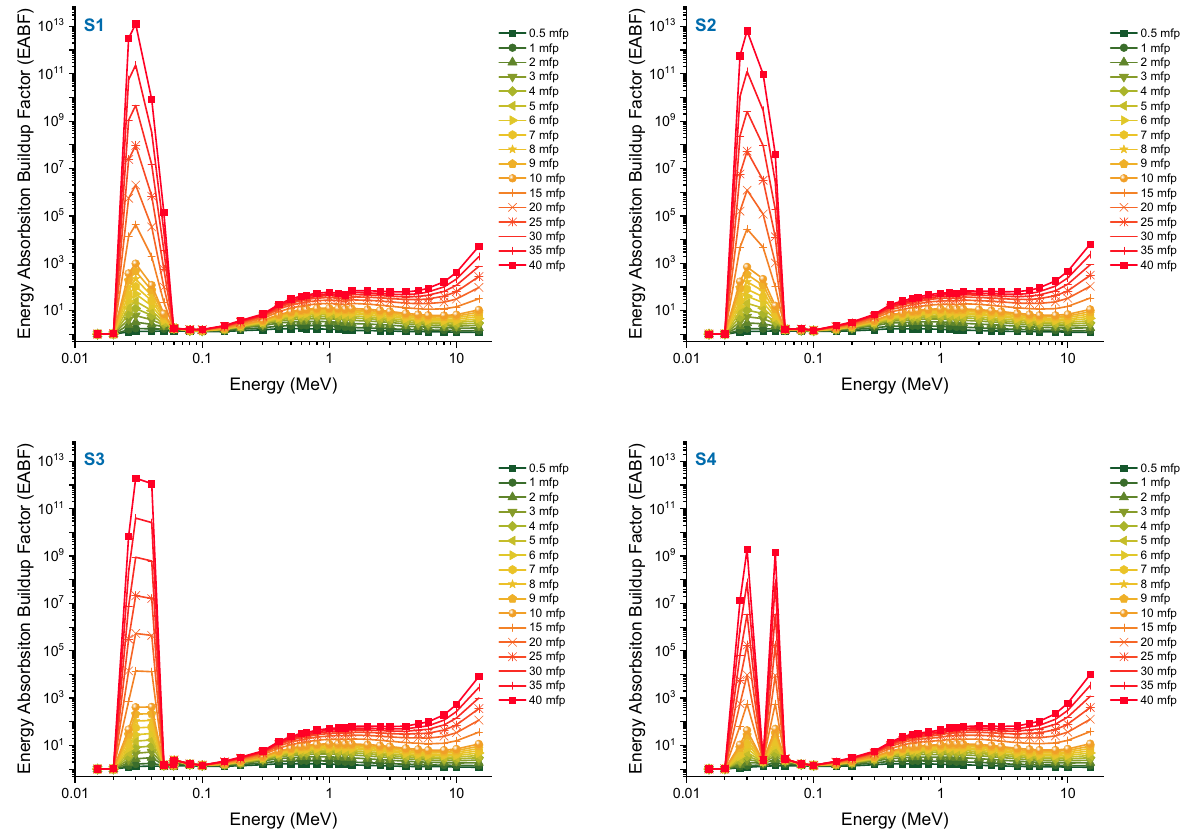
Figure 11: Variation in EABF of investigated glasses at di ff erent mfp